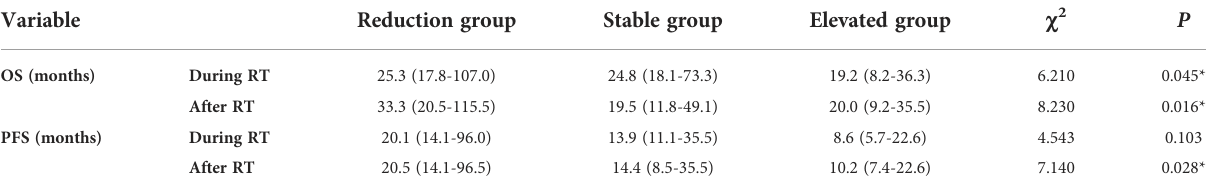
TABLE 4 Survival analysis of VEGF reduction group, stable group and elevated group during/after radiotherapy.